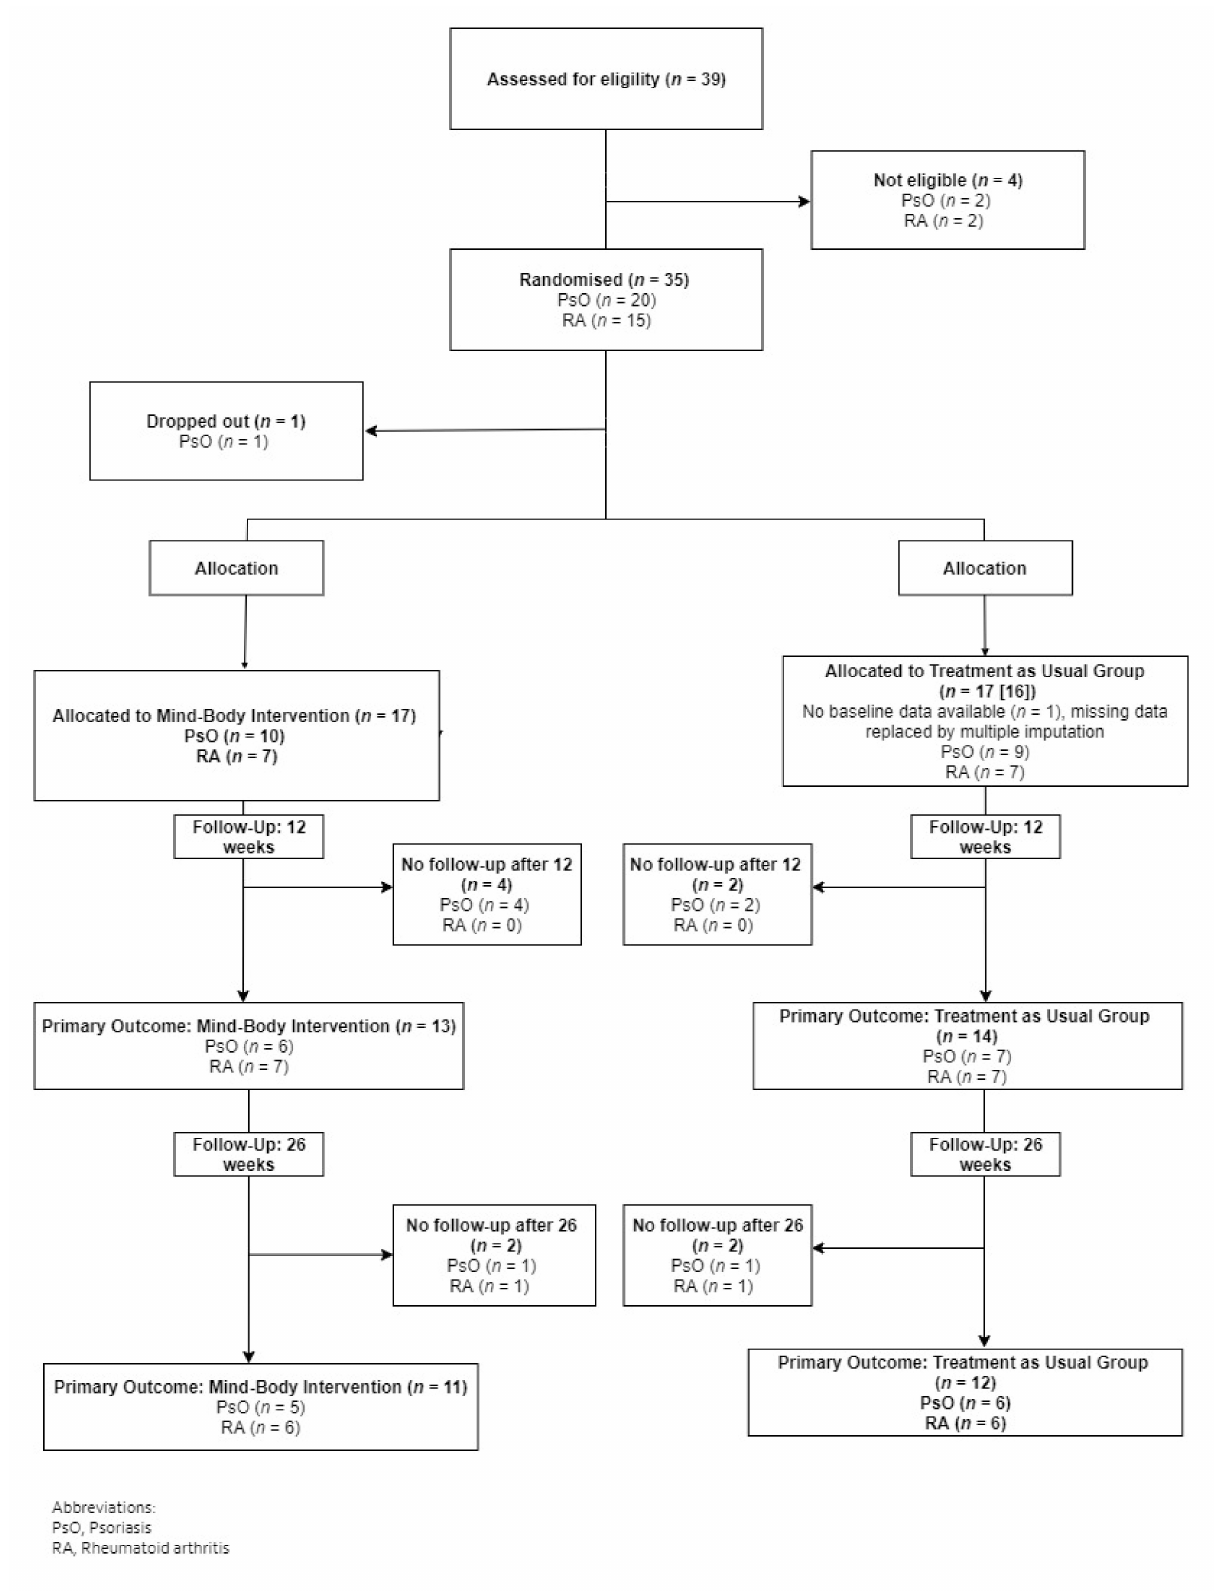
Figure 1. Trial Flow